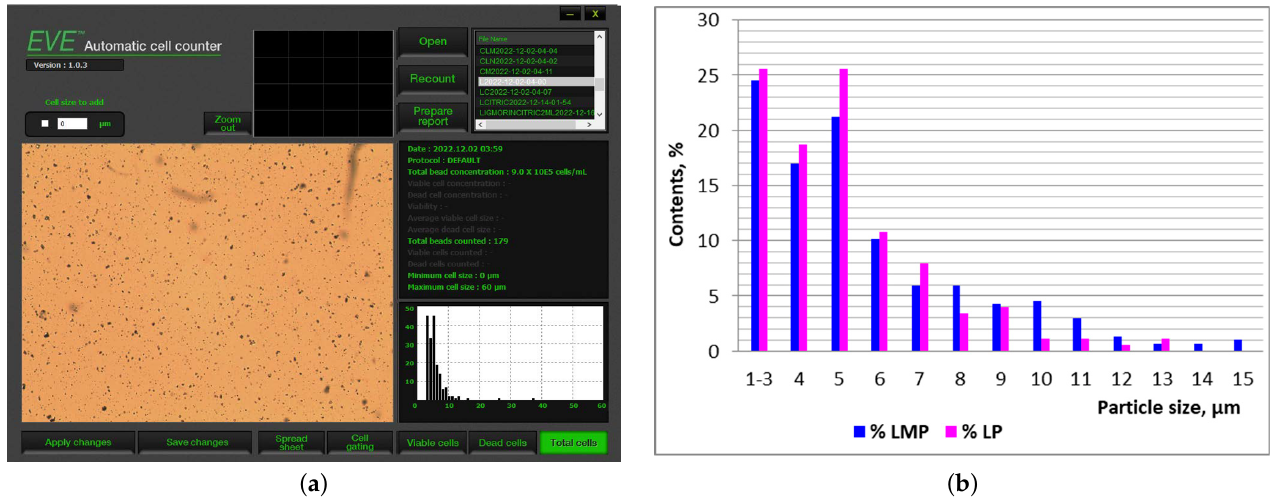
Figure 1. ( a ) Lignin microparticles EVE automatic beads counter image; ( b ) LP and LMP particle size distribution in 1 µL suspensions.